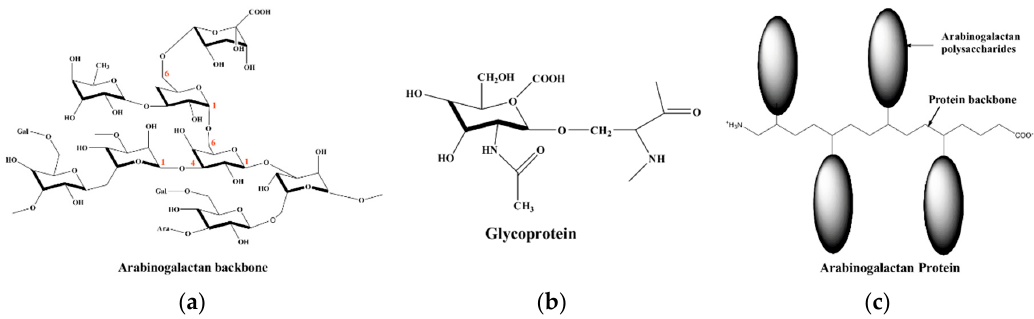
Figure 15. Structure of gum arabic: ( a ) arabinogalactan; ( b ) glycoprotein; ( c ) arabinogalactan ‐ protein.